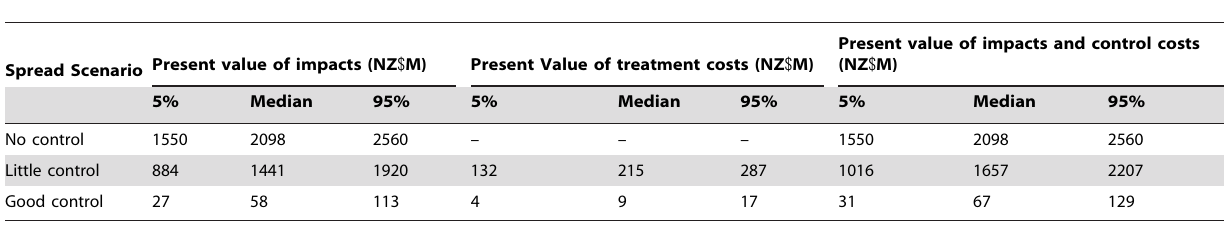
Values are discounted at 7% and accumulated over the 30 year period. 5%, median and 95% are results for different quantiles in the stochastic spread simulations.